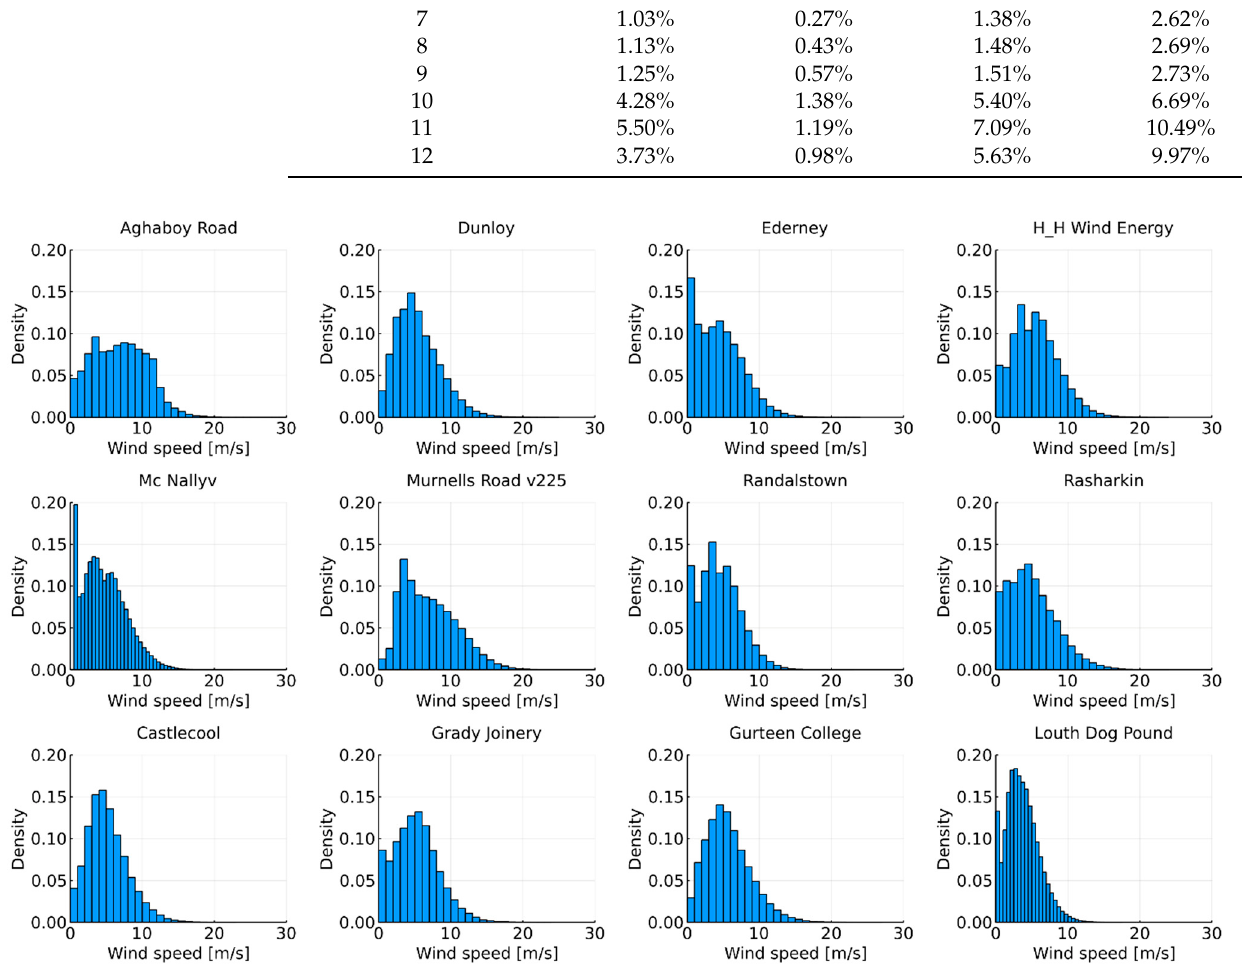
Figure 6. Wind speed distributions of the 12 selected locations.